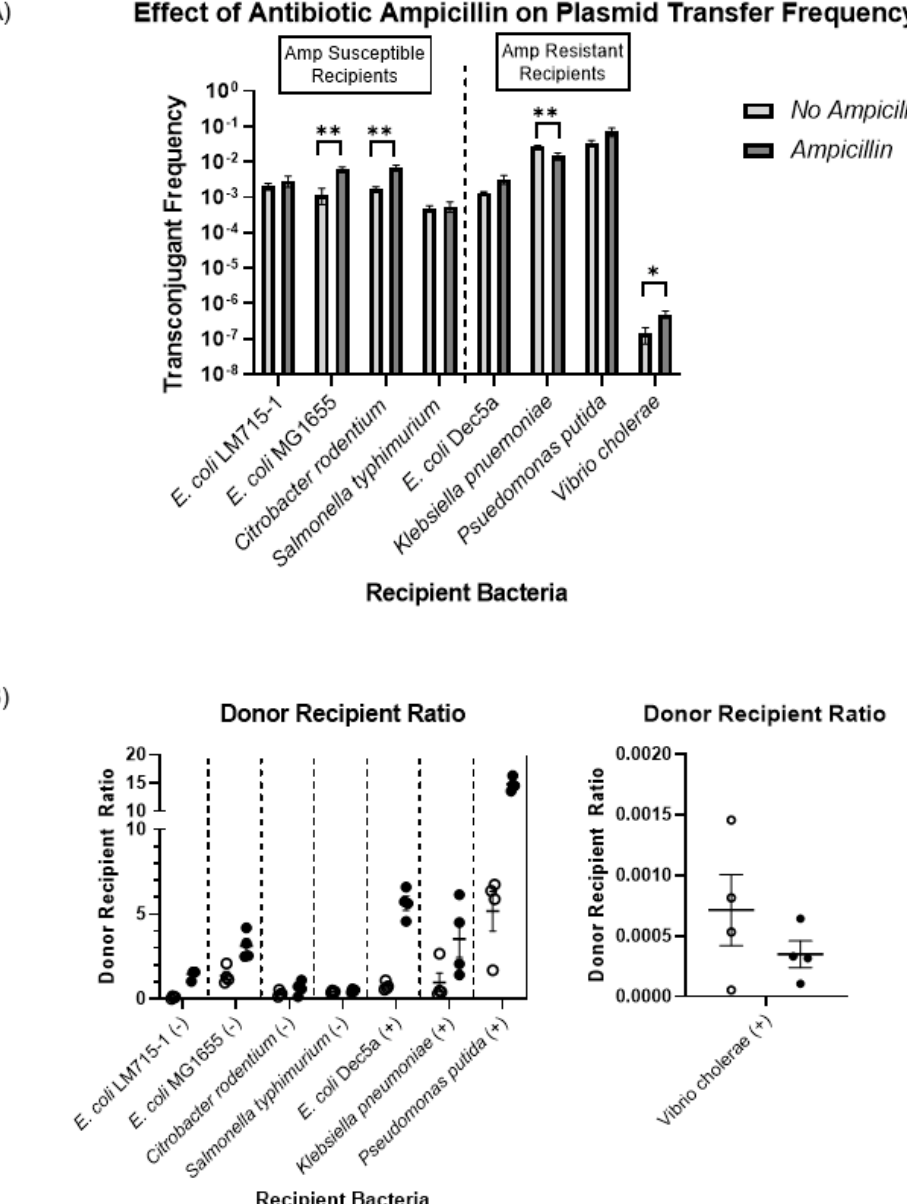
Figure 3. Effect of ampicillin on plasmid transfer frequency. ( A ) Plasmid transfer frequencies for all recipients as calculated using the formula (plasmid transfer frequency = transconjugants/(transconjugants + recipients)). Bars show mean values ± standard error of the mean (SEM) based on four independent replicates (n = 4). For each recipient, frequency of transfer from E. coli LM715-1:RP4 in the absence of ampicillin was compared to the transfer frequency in the presence of ampicillin. An unpaired independent samples t- test was performed to calculate p values; only significant p values are annotated in the graph: * = p ≤ 0.05, ** = p ≤ 0.01. ( B ) Donor-to-recipient ratio with and without ampicillin. The ratio was calculated using the total number of donor and recipient bacteria after 24 h of incubation on filter paper for conjugation on Luria agar plates with and without ampicillin. Circles show four independent replicates (n = 4) performed for each ampicillin-treated (filled circles) and untreated (empty circles) group. Bars show mean values ± standard error of the mean (SEM) based on replicates in each group. A negative symbol ( − ) in parenthesis indicates sus- ceptibility to ampicillin, and a positive sign (+) indicates resistance to ampicillin. The transconjugant frequency shown in ( A ) was computed using the same number of recipient bacteria used to calculate the donor-to-recipient